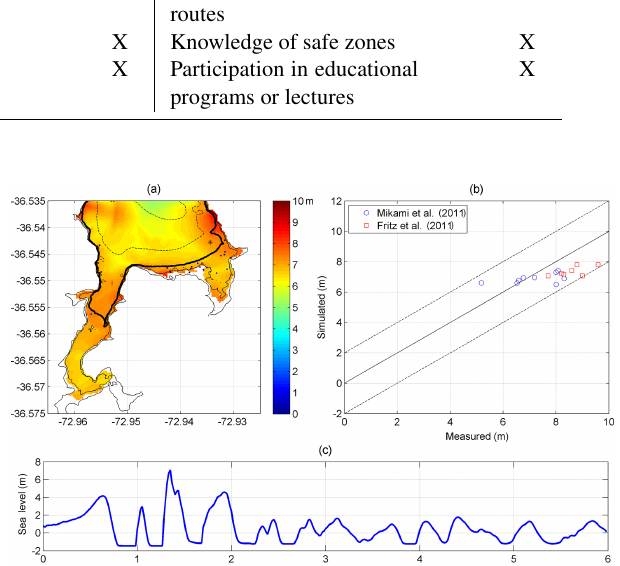
Table 3. Variables associated with each dimension of vulnerability pre- and post-2010 tsunami. Physical dimension Socioeconomic dimension Educational dimension Variable Pre Post Variable Pre Post Variable Pre Post Housing type X X Population density X Level of knowledge of the X X phenomenon Housing material X X Overcrowding level X Knowledge of tsunami warning systems Number of houses X Socioeconomic welfare of X Reaction to the event households Number of floors X Education level X Knowledge of evacuation routes Labor activity Knowledge of safe zones Per capita income